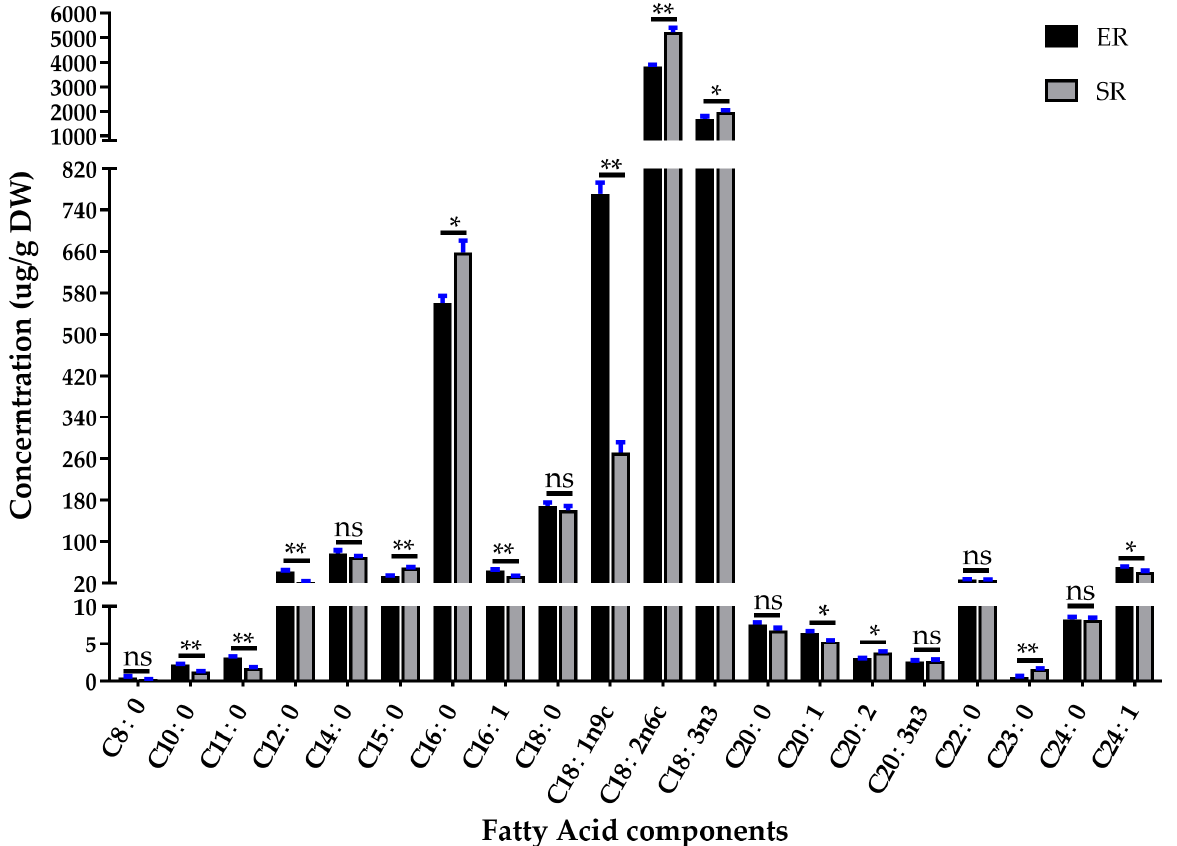
Figure 12. Fatty acid components of elongation region (ER) and stable region (SR). Significance levels were calculated by paired t -test ( n = 4), * p < 0.05, ** p < 0.01, ns: no significance.